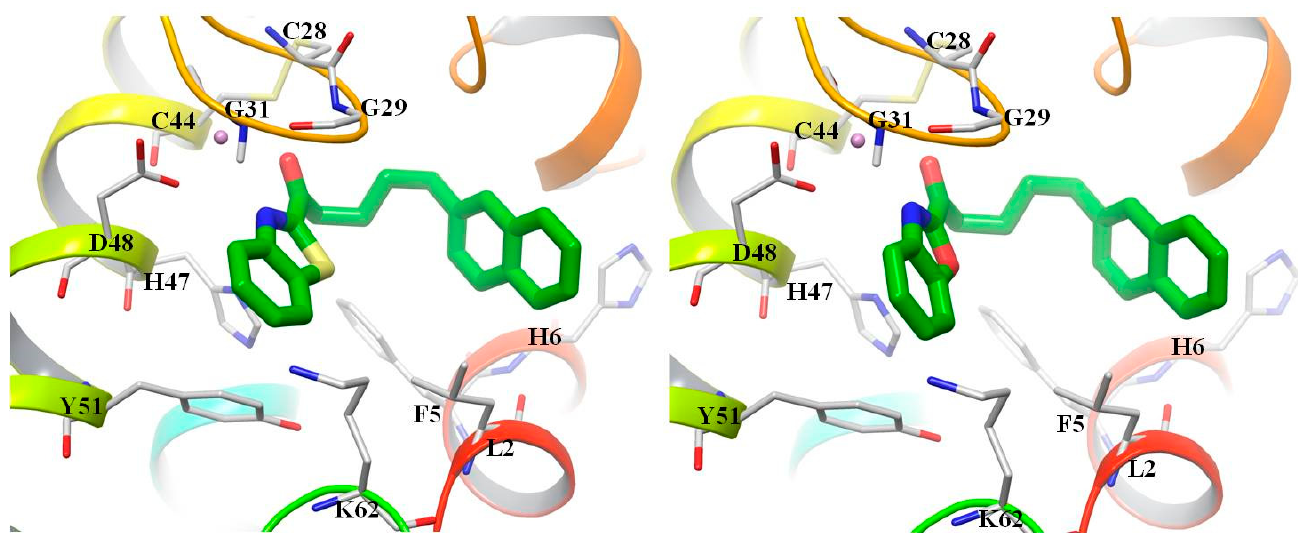
Figure 9. Proposed binding modes of GK181 (left) and GK491 (right) in the active site of GIIA sPLA 2 (PDB:1KQU). The purple ball is Ca 2+ , which coordinates with Asp48 and the glycine loop (Gly29, Gly31). The inhibitors are involved in π – π interactions with His6 and the catalytic His47.